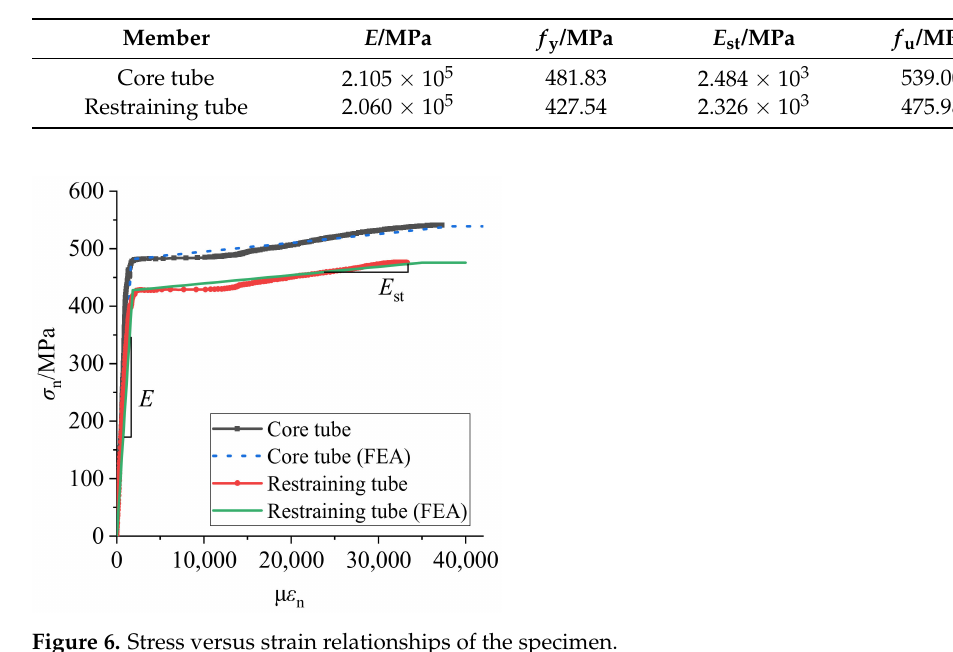
Table 2. Material properties.